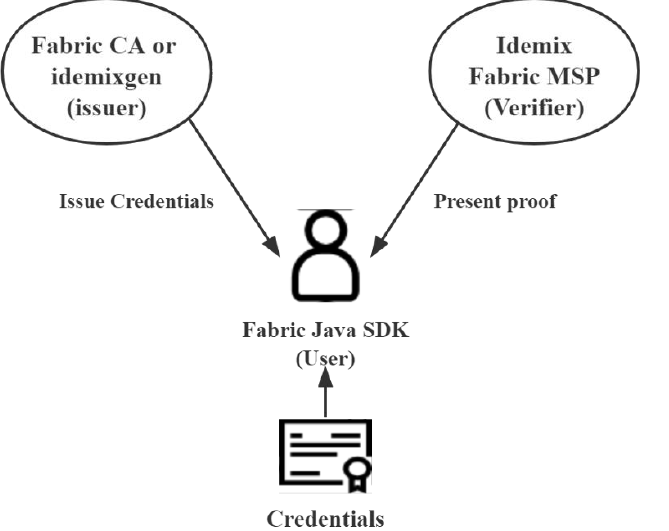
Figure 9. CA authentication process.